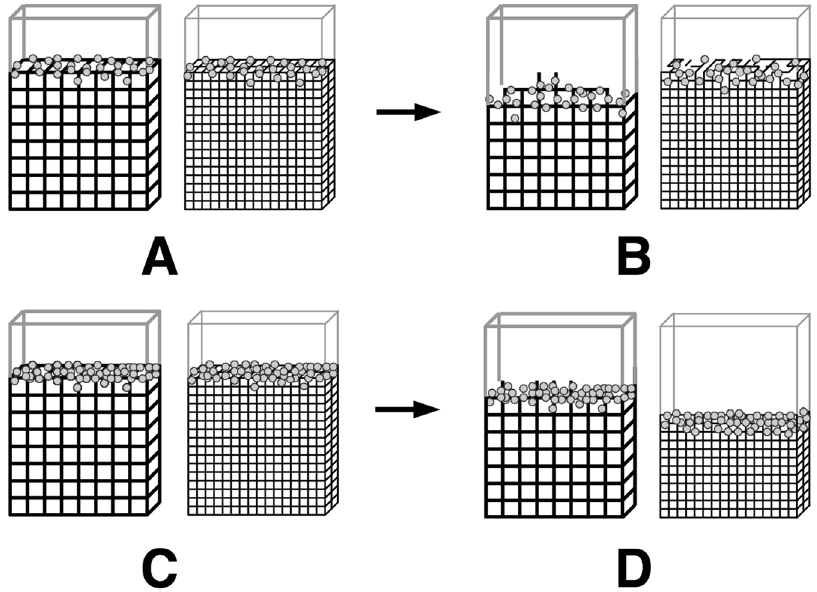
Figure 6. Schematic of the interplay between clot structure and tPA. Each subfigure depicts a coarse clot with thick fibers (left) and a fine clot with thin fibers (right) contained in the same volume. Round symbols represent bound tPA molecules. ( A , B ) When there is not much tPA present, the coarse clot degrades faster because it has fewer fibers; the small number of tPA molecules is able to start degradation on all fibers at the coarse clot front, but is unable to do so at the fine clot front. ( C , D ) When there is a lot of tPA present, degradation begins on all fibers at the front of both clot types. In this case, the fine clot degrades faster since the individual thin fibers in the fine clot are lysed faster than the individual thick fibers in the coarse